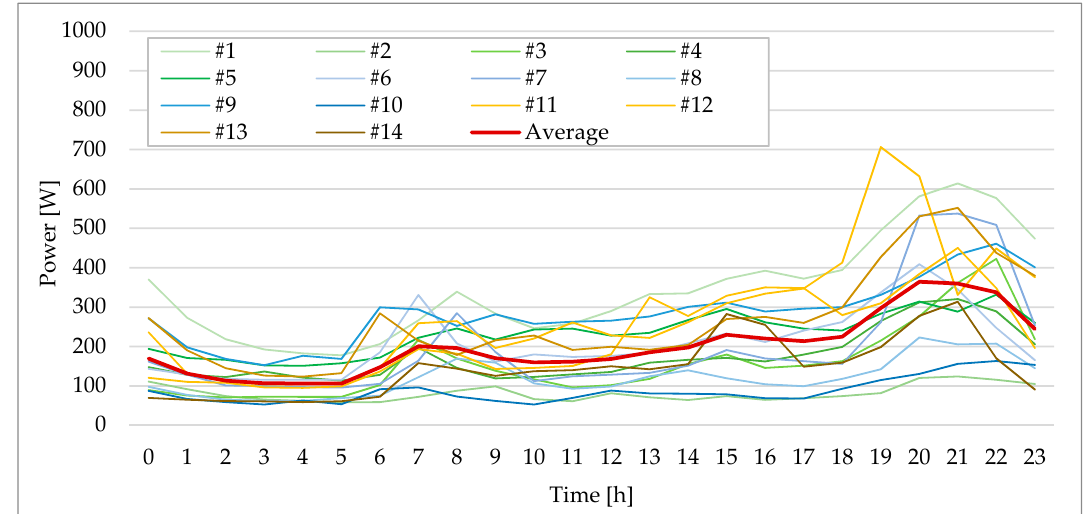
Figure 6. Archetypes average daily profiles over the weekdays.